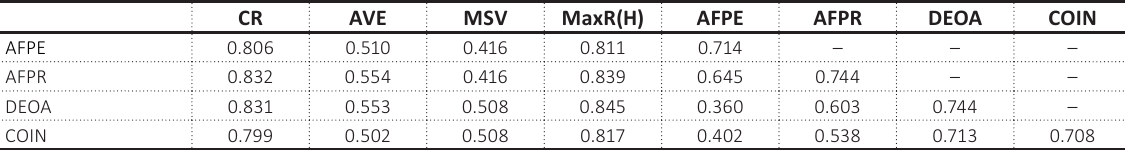
Table 5. Reliability and validity of the